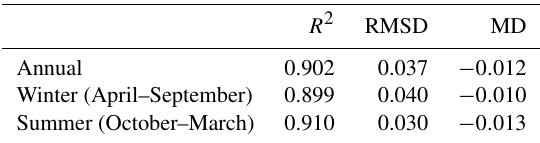
Table 1. Comparison of ¯ α(t ) between Mask 1 and Mask 2 from Terra MODIS images between 25 February 2000 and 30 April 2018. Statistics are calculated as average values from the 12 outlet